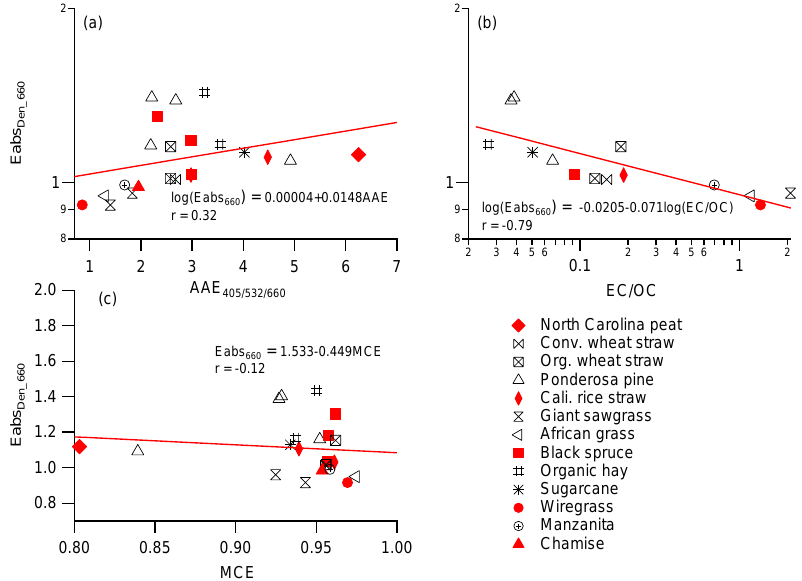
Figure 6. Same as Fig. 5 but for